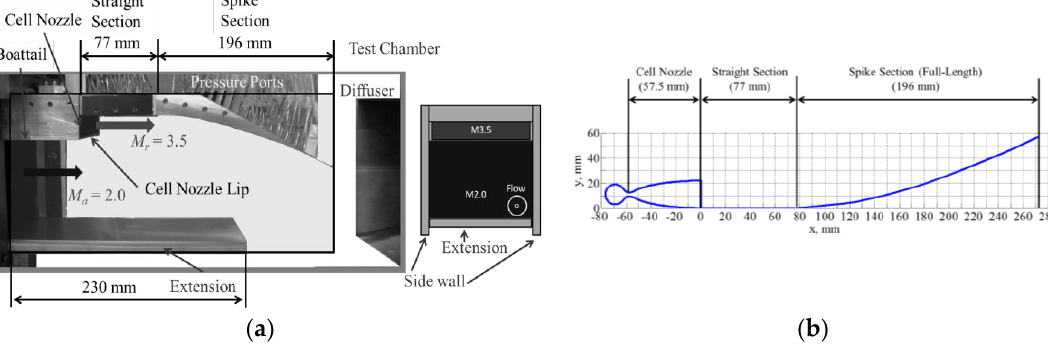
Figure 2. Geometric schematics used in the experiment, photograph of experimental setup for the full-length spike model, and contour geometries; ( a ) photograph of experimental model setup; and ( b ) contour geometries for 2D cell and spike nozzles.